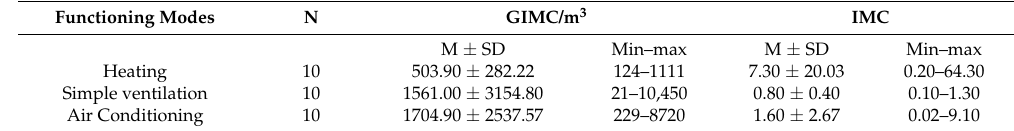
Table 2. Global index of microbial contamination per cubic meter (GIMC/m 3 ) and index of mesophilic bacterial contamination (IMC) measured in offices during heating, air conditionining and simple